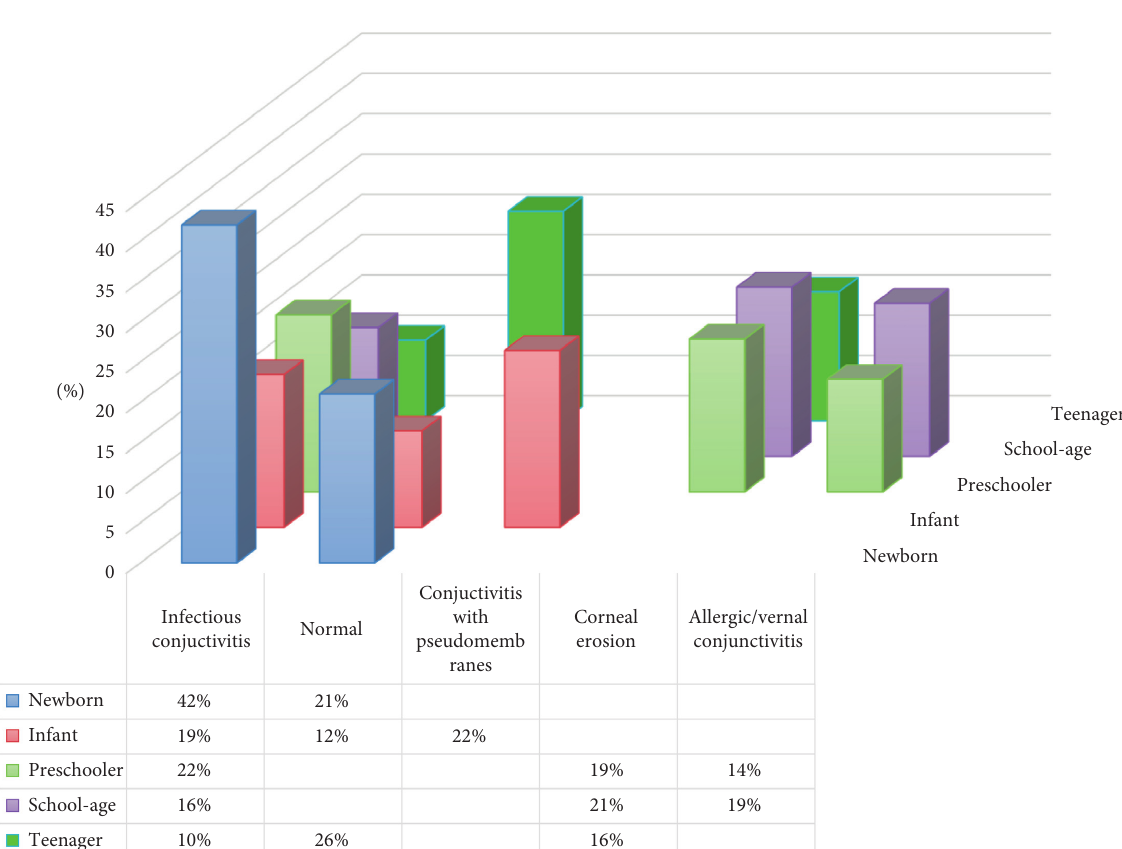
Figure 7: Distribution of the most frequent diagnoses according to age.